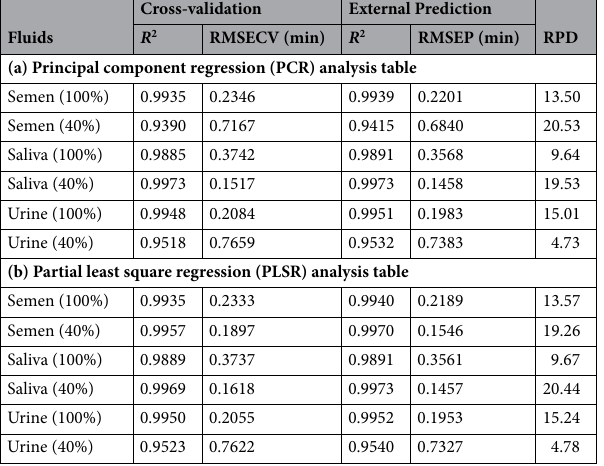
Table 4. (a) Validation results of PCR models for multiple age-linked peaks of three body fluids, (b) validation results of PLSR models for multiple age-linked peaks of three body